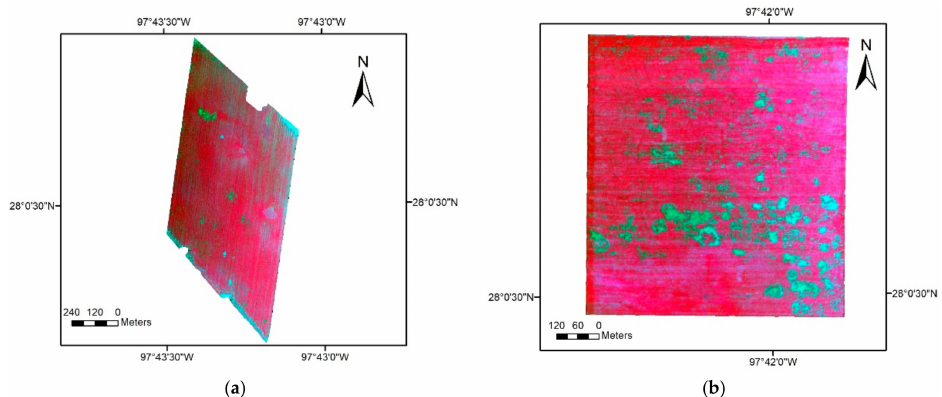
Figure 2. Color-infrared composite images derived from hyperspectral images for two fields: ( a ) Field A and ( b ) Field B.